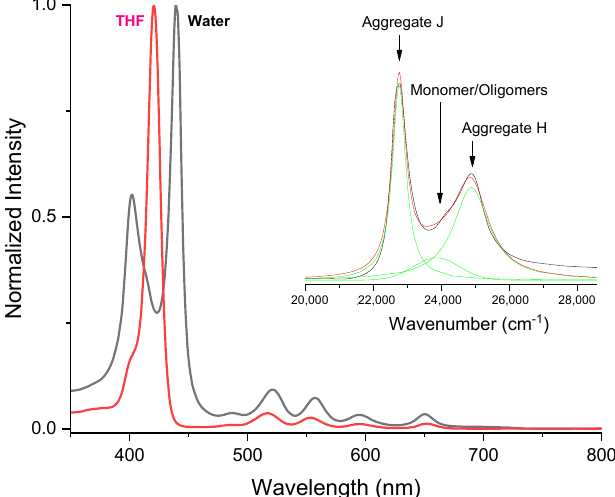
Figure 2. Normalized UV-Vis spectra of the water (black line) and THF (red line) solutions of StarP (~6 µ M in both solvents). In the inset, deconvoluted curves (green lines) and fitted curve (red line) of the UV-Vis spectrum of the StarP aqueous solution (black line).